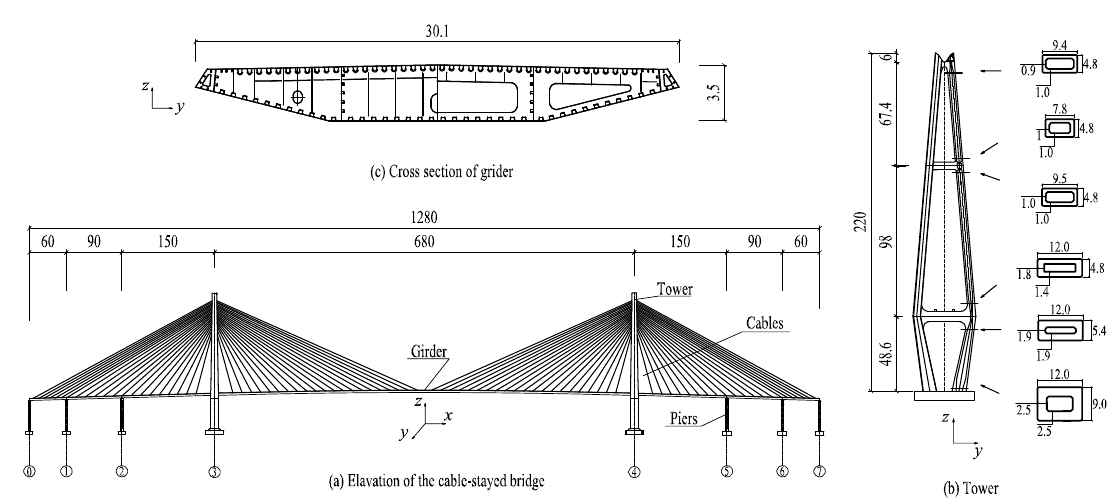
Figure 1. ( a ) Elevation of the CSB; ( b ) the cross section of girder; ( c ) the main tower.